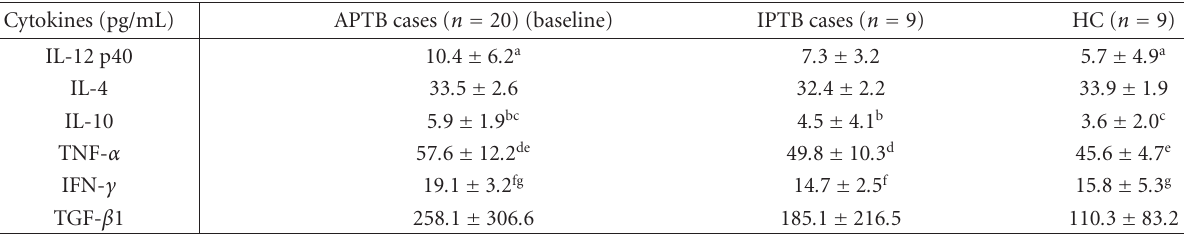
Table 1. Serum levels of cytokines in active pulmonary tuberculosis (APTB) cases, inactive pulmonary tuberculosis (IPTB) cases, and healthy controls (HC). Cytokines